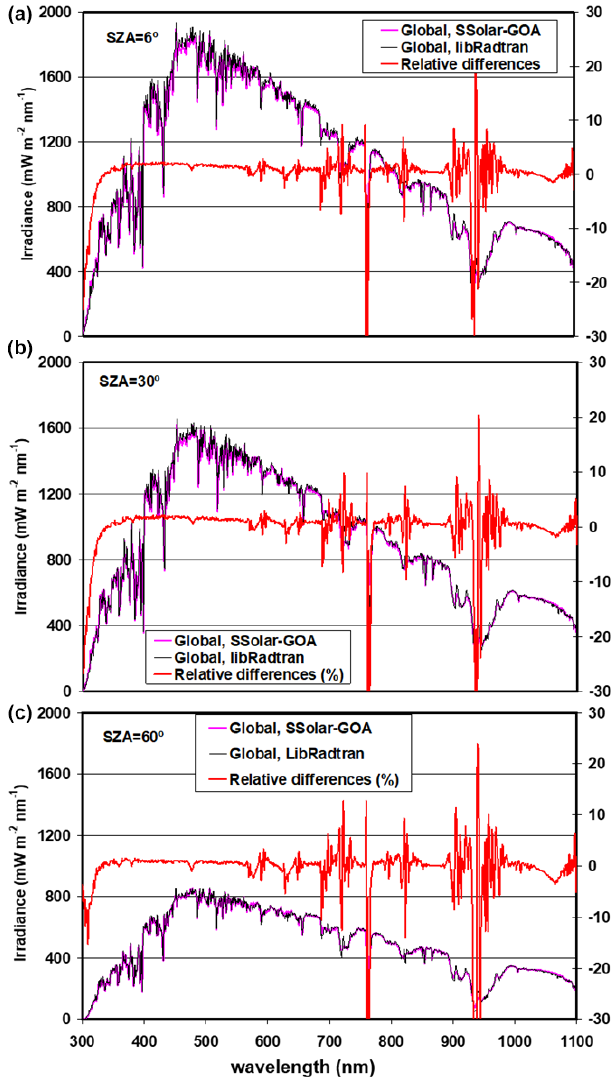
Figure 5. Comparison between libRadtran and SSolar-GOA mod- els for global irradiance at SZA = 6, 30, and 60 ◦ , respectively (from top to bottom), with input parameters shown at the top of Fig. 3. Right y axis indicates the relative differences in percentage ((li- bRadtran − SSolar-GOA) /